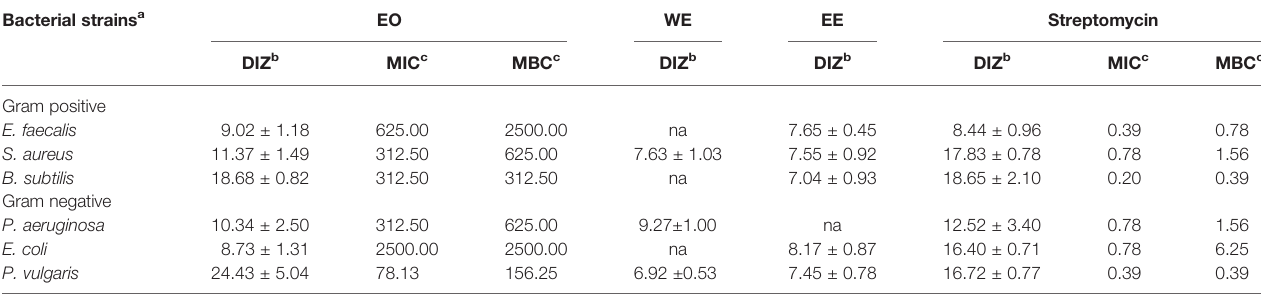
The MIC and MBC of WE and EE were not listed in the table cause for being not detected at 2500 g/mL. a Bacterial strains: Enterococcus faecalis (ATCC 29212), Staphylococcus aureus (ATCC 6538P), Bacillus subtilis (CMCC (B) 63501), Pseudomonas aeruginosa (CMCC (B) 10104), Escherichia coli (ATCC 25922), and Proteus vulgaris (CMCC (B) 49027). b DIZ: The diameter of the inhibition zones (mm) including the diameter of the disk (6 mm). Sample solution: Pure EO (tested volume: 20 m L); WE and EE distilled water solution (tested